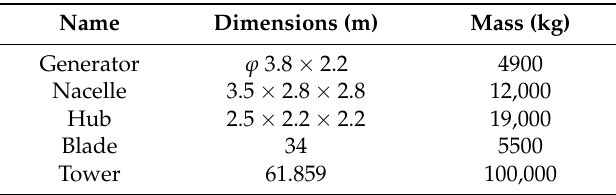
Table 2. Specifications of wind turbine.